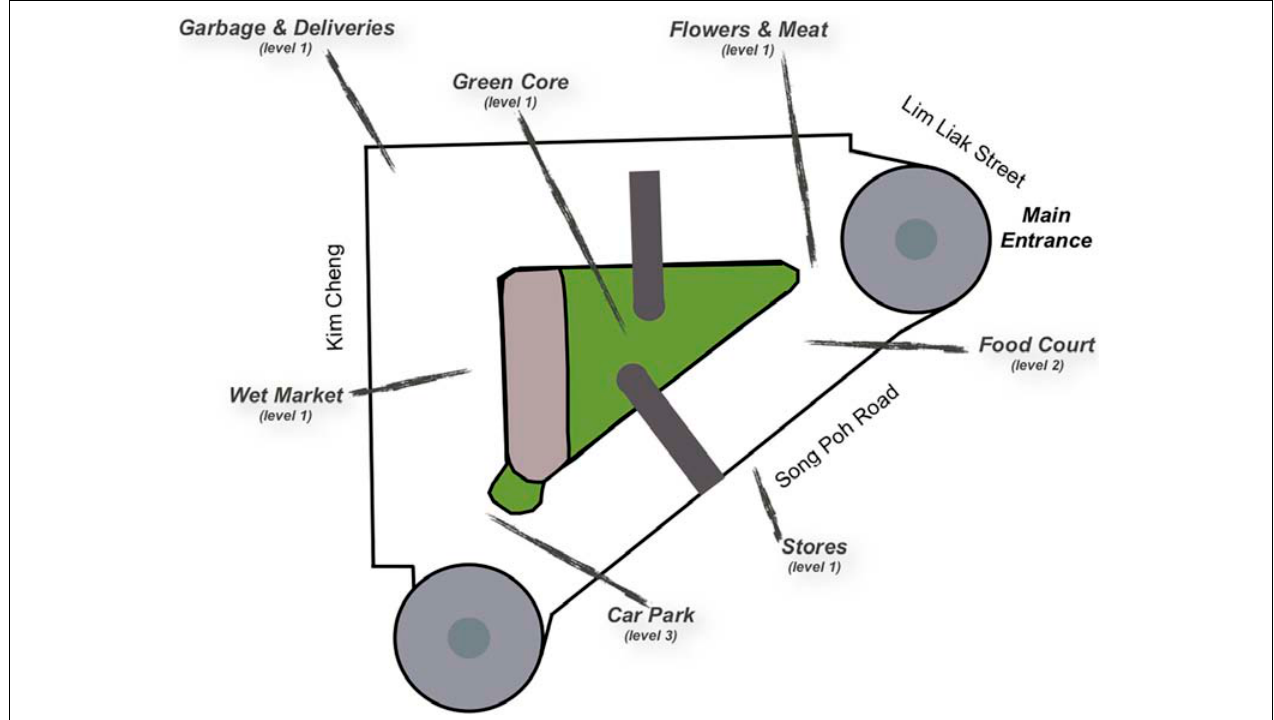
FIGURE 2 | Overview of Tiong Bahru Market marking out the seven locations of the sensory